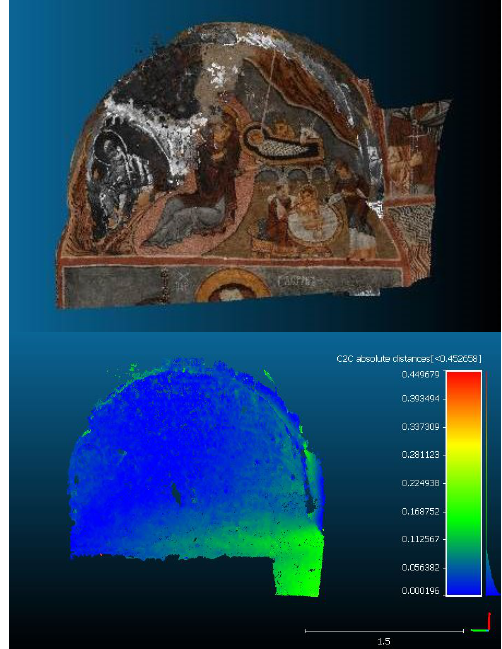
Figure 9. Cloud to cloud distance for the Karanlık